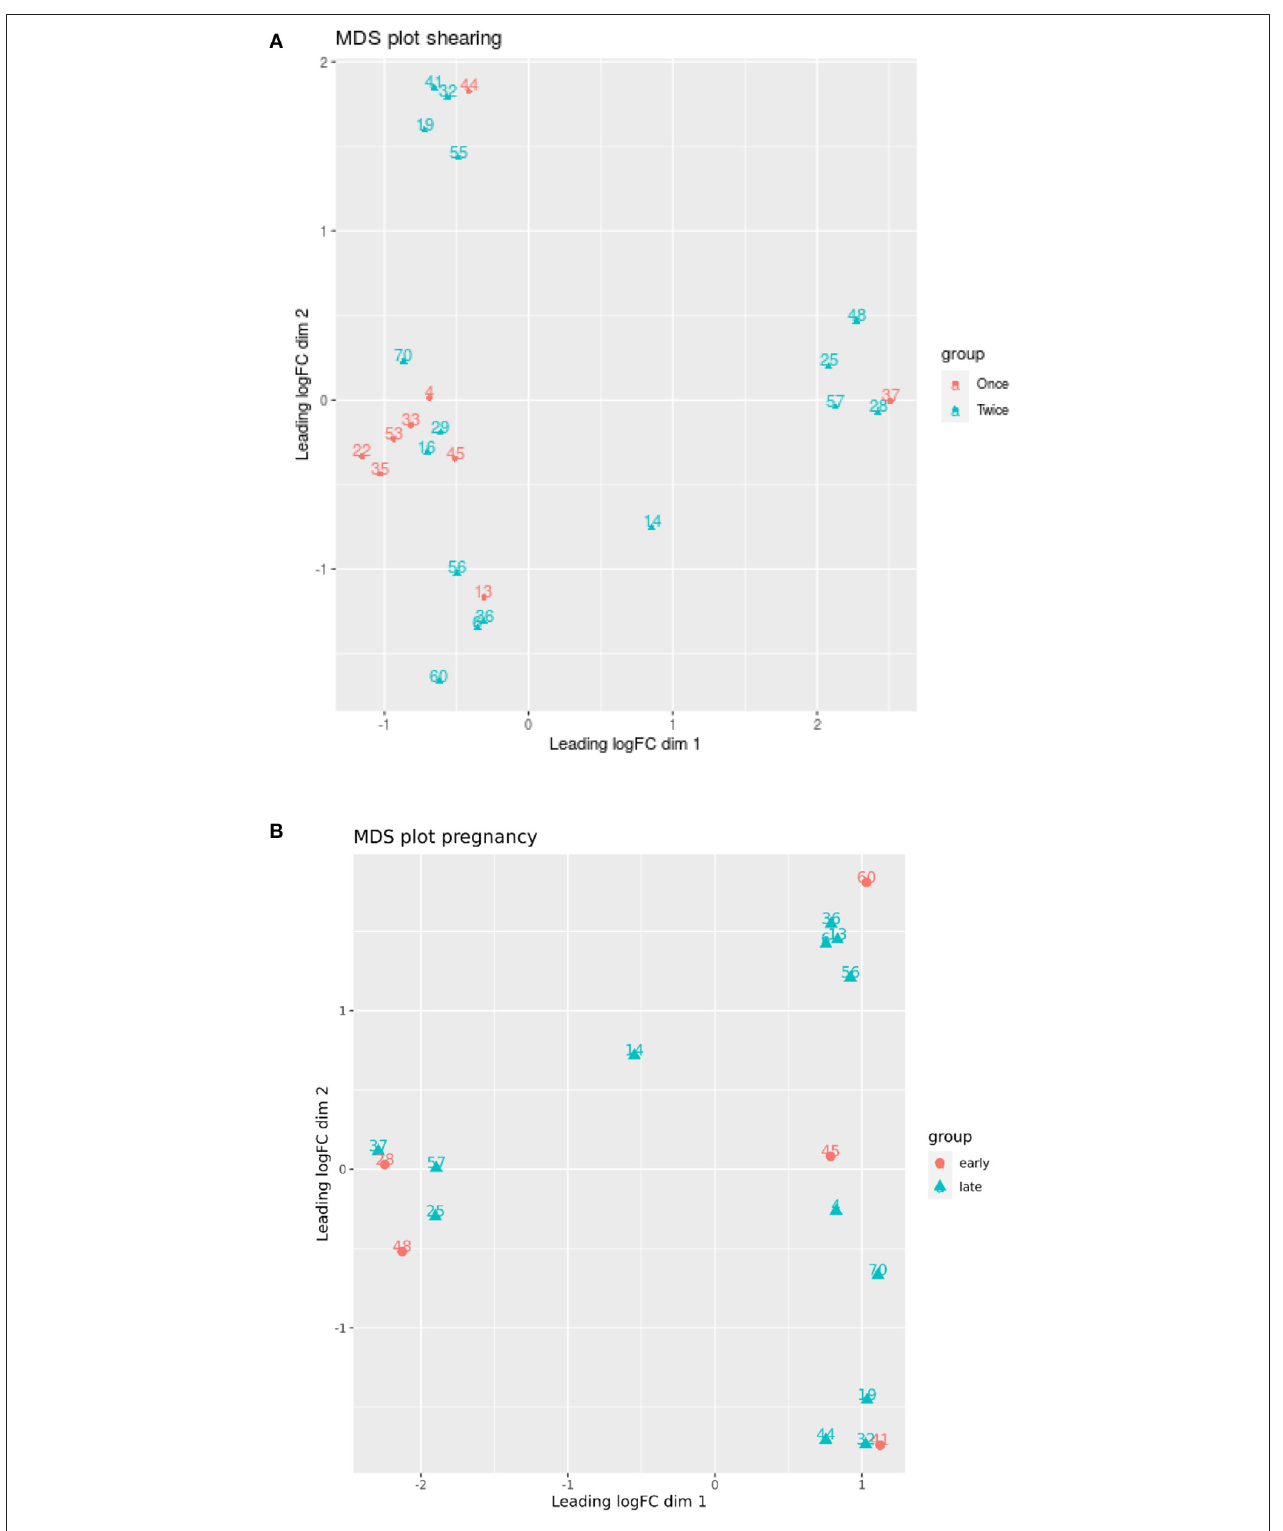
FIGURE 7 | (A,B) Multidimensional scaling (MDS) plot based on all methylation sites. Each dot represents a lamb sample and is colored by the pregnancy duration (early vs. late) and shearing treatment (once vs. twice). Only the 50 most significant loci were used for the MDS analysis.